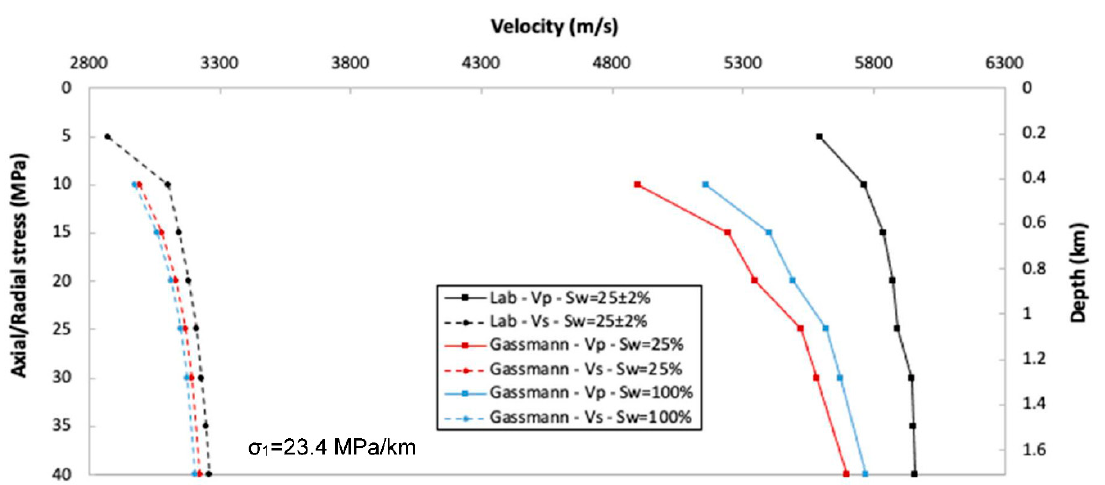
Figure 17. P-wave (continuous lines) and S-wave (dashed lines) velocities as a function of axial stress, and thus depth below the surface, for the (partly) saturated calcschist sample (TD12-CS4) discussed in Section 3.6. Experimental data are shown in black whereas modeled velocities, according to Gassmann fluid substitution [40], for saturations of 25 and 100% are presented in red and blue, respectively. The equations used (Equations (S1) to (S4)), stress-dependent bulk moduli and densities (Table S2), and a short description of Gassmann’s fluid substitution is presented in the Supplementary Materials. Axial stress–depth relationship is taken from [35].